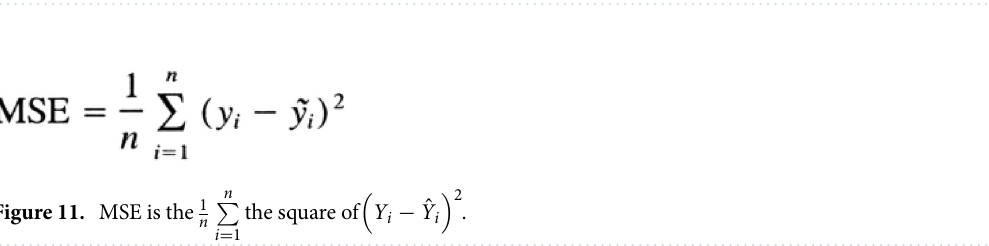
Figure 10. Microscopy images of the 3T3 cell line in different dimensions. ( a ) Original image. ( b ) Cropping 75% of the image. ( c ) Cropping 50% of the image. ( d ) Cropping 25% of the image.